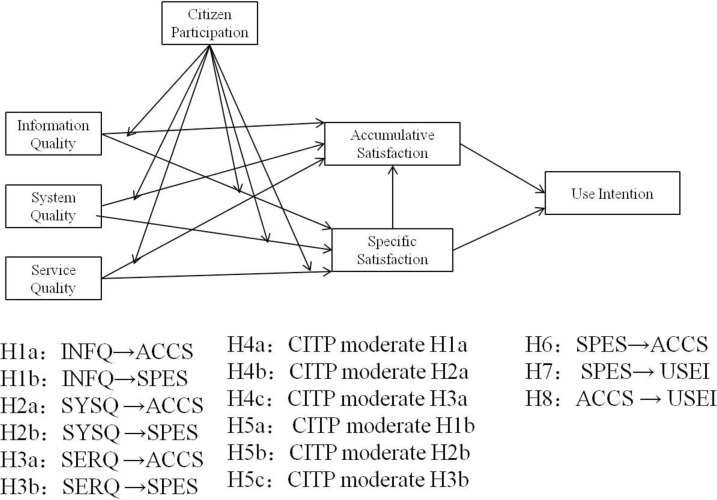
Research model with the hypothesis.